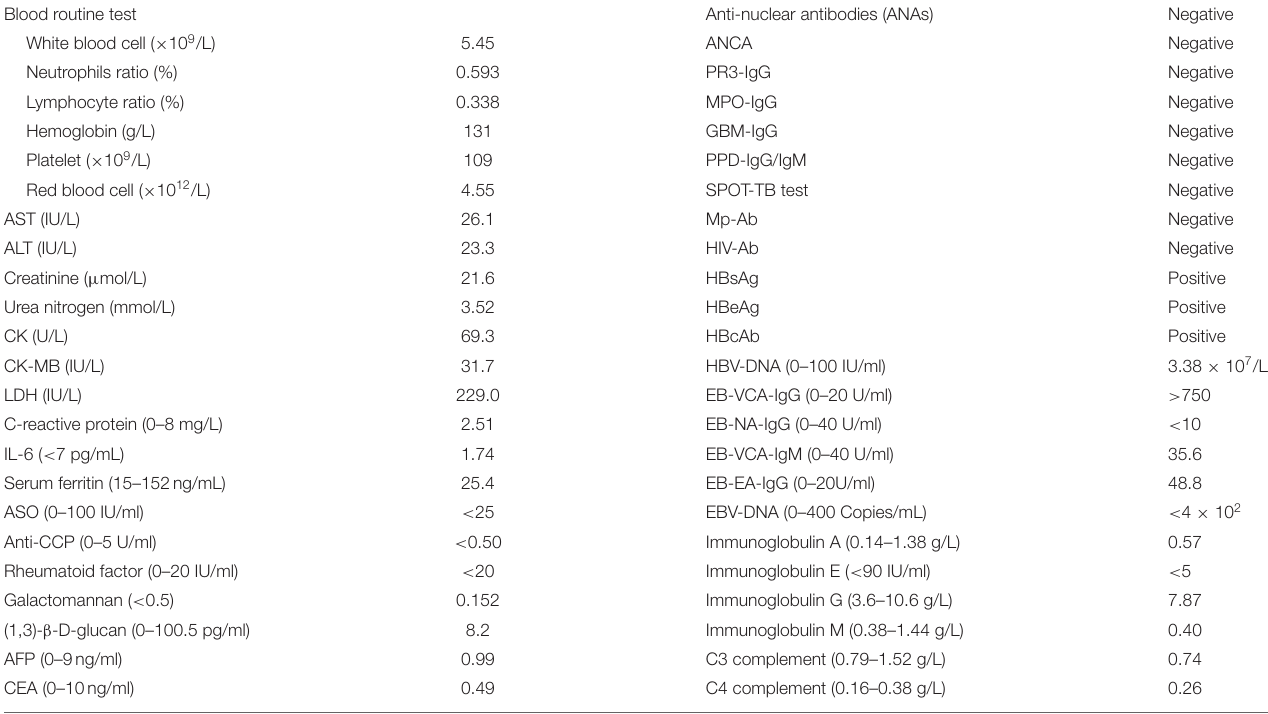
TABLE 1 | Laboratory examination results after hospitalization. Blood routine